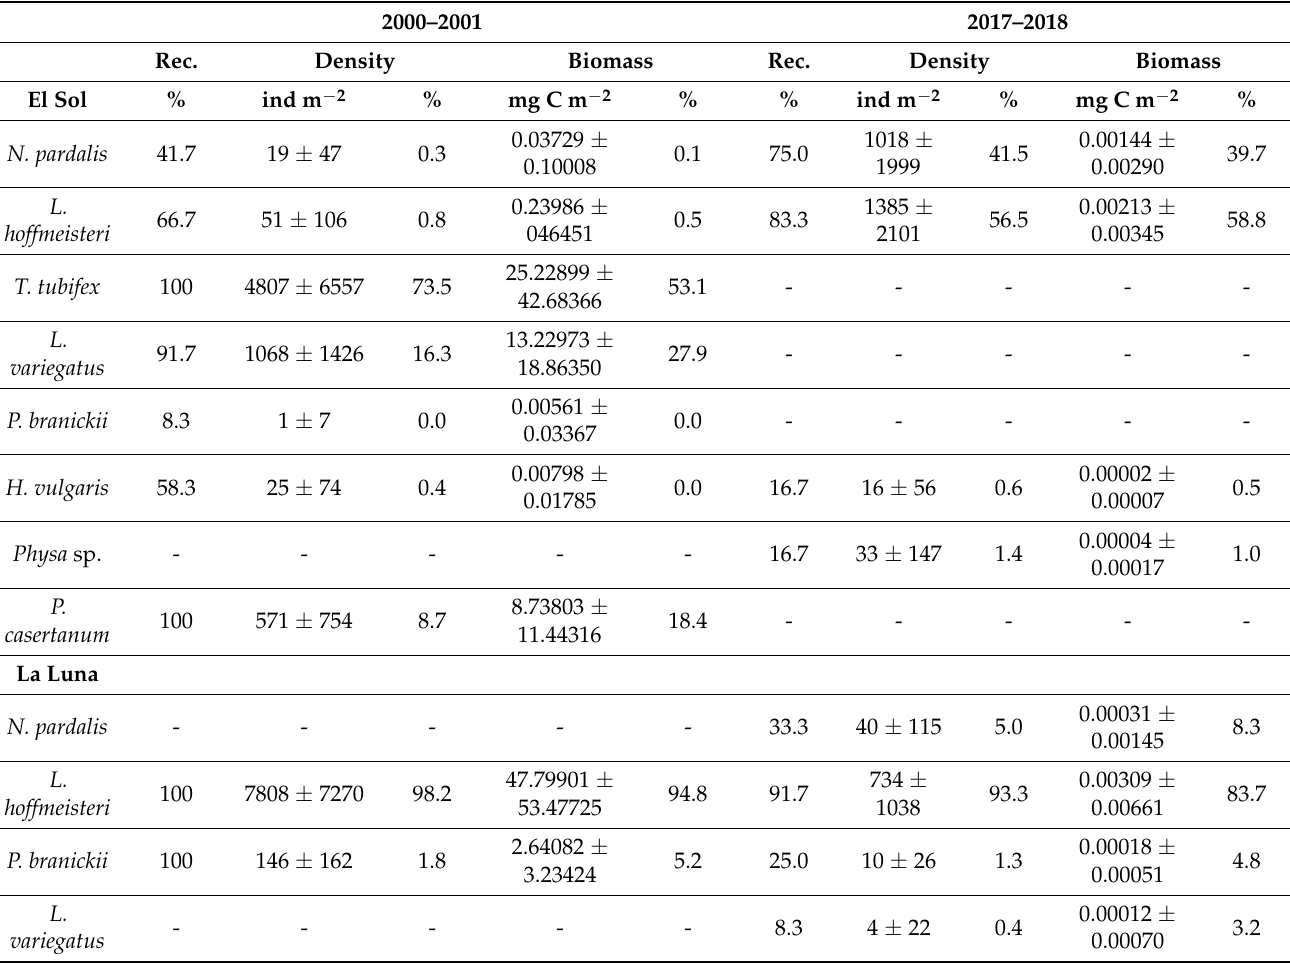
Table 4. Recurrence percentage (Rec.), and BMI density and biomass (average ± standard deviation and % of annual density and biomass) of Lakes El Sol and La Luna, Nevado de Toluca, measured in 2000–2001 and in 2017–2018.